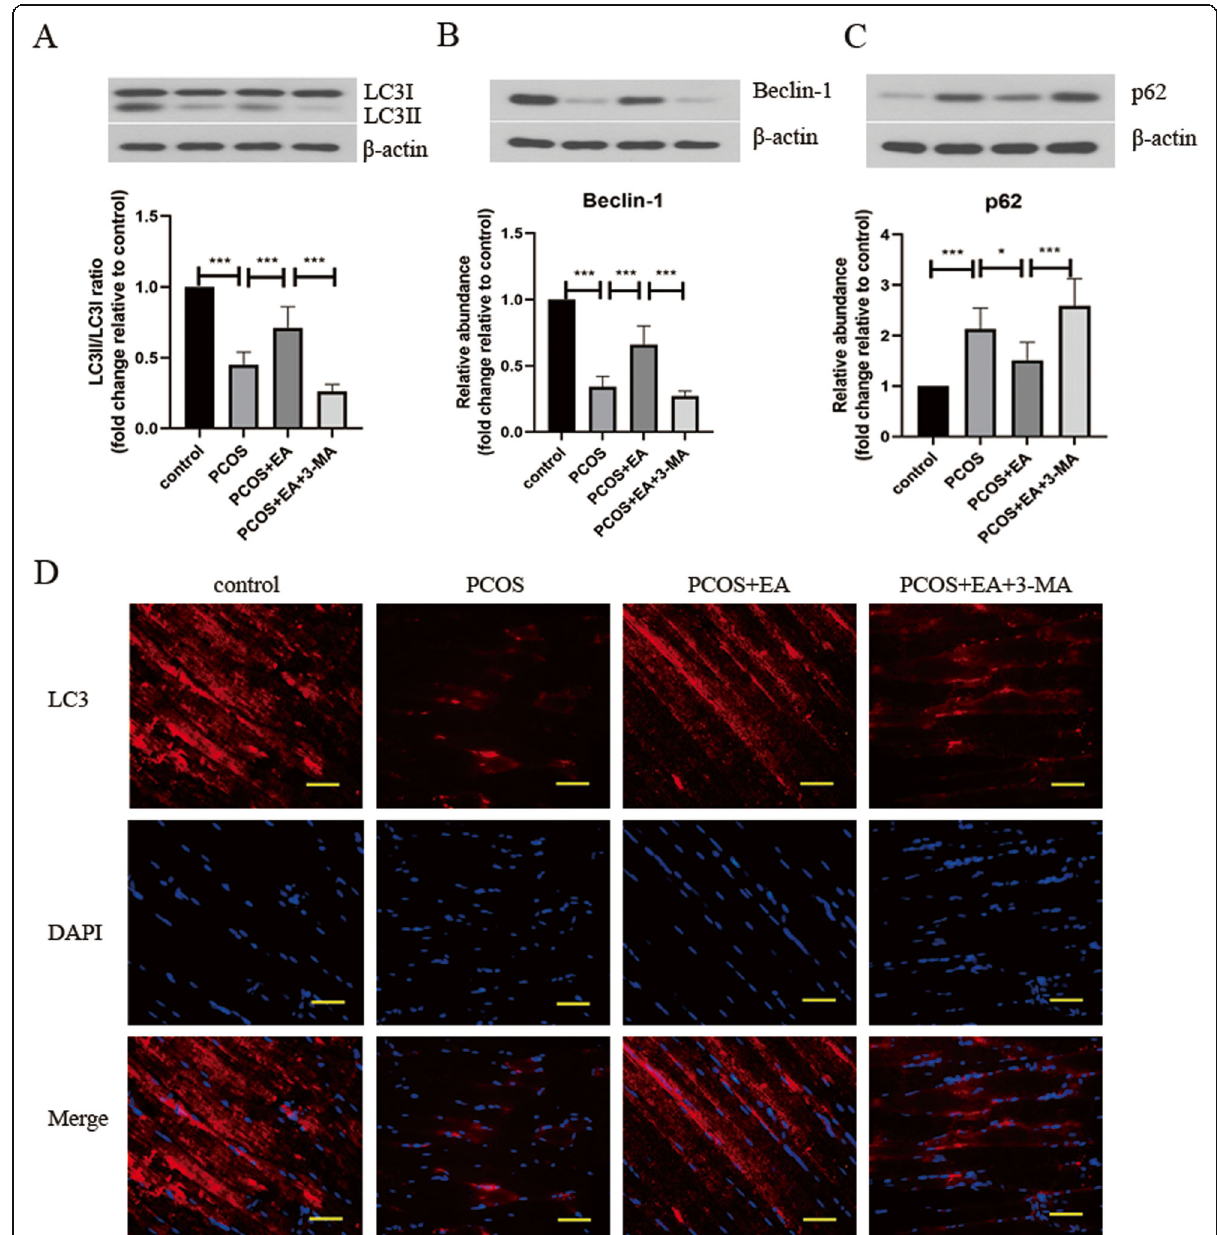
Fig. 2 Effect of EA on autophagy in PCOS. The protein levels of LC3I/II ( a ), Beclin-1 ( b ), and p62 ( c ) in the skeletal muscle tissues were detected by Western blotting. d The expression of LC3 in skeletal muscle tissues was observed by immunofluorescence staining (400×). Scale bar is 50 μ m. The experimental data are presented as mean ± standard deviation (n = 6). * P < 0.05, *** P < 0.001, vs the indicated group.